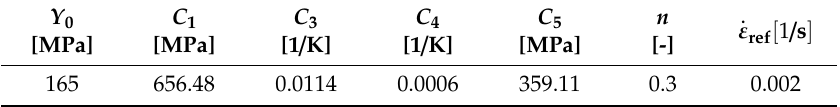
Table 2. ZA-parameters used for generating large tabular input for the numerical